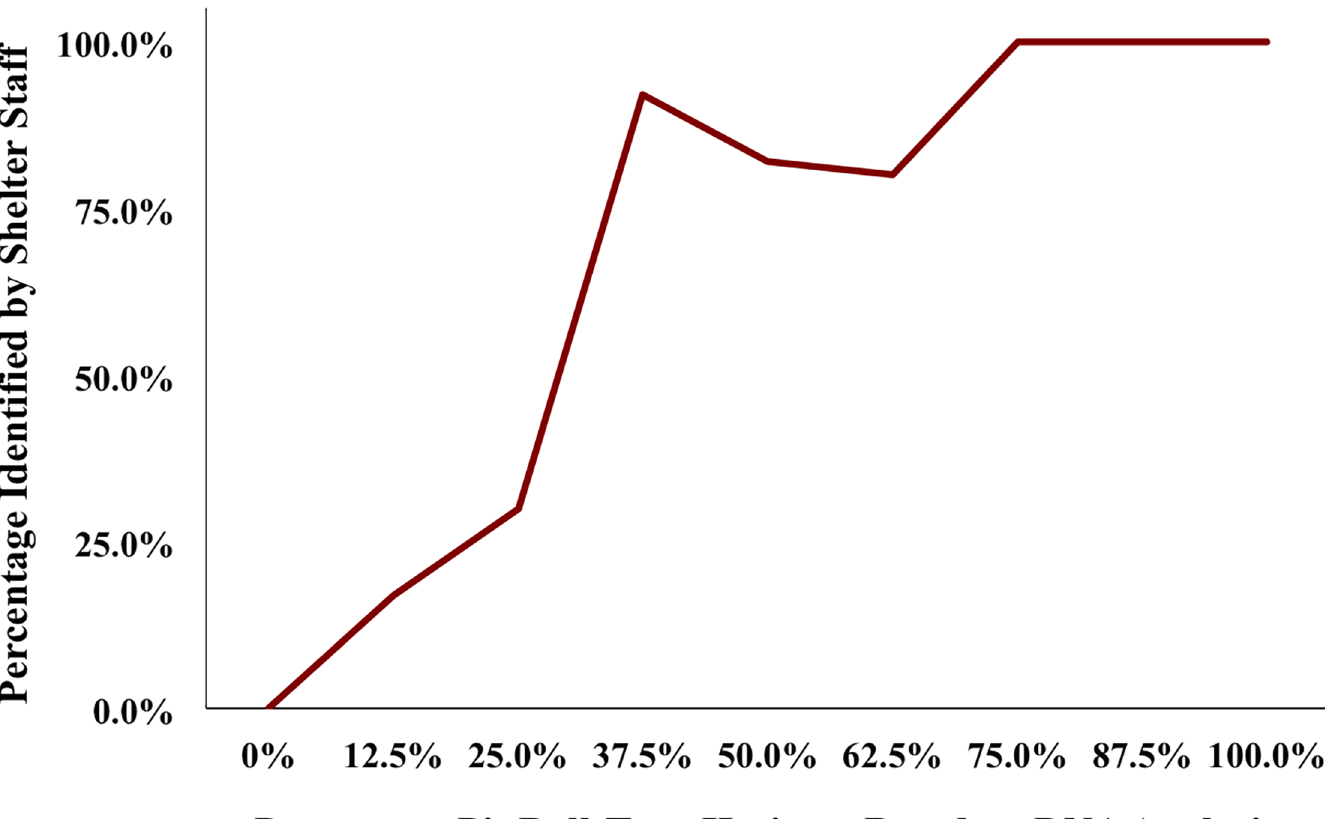
Fig 2. Percentage of pit bull-type dogs matched and mismatched by shelter staff by percentage of pit bull-type